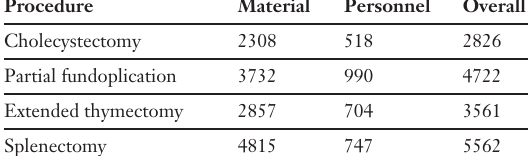
Procedural costs per patient (median in D